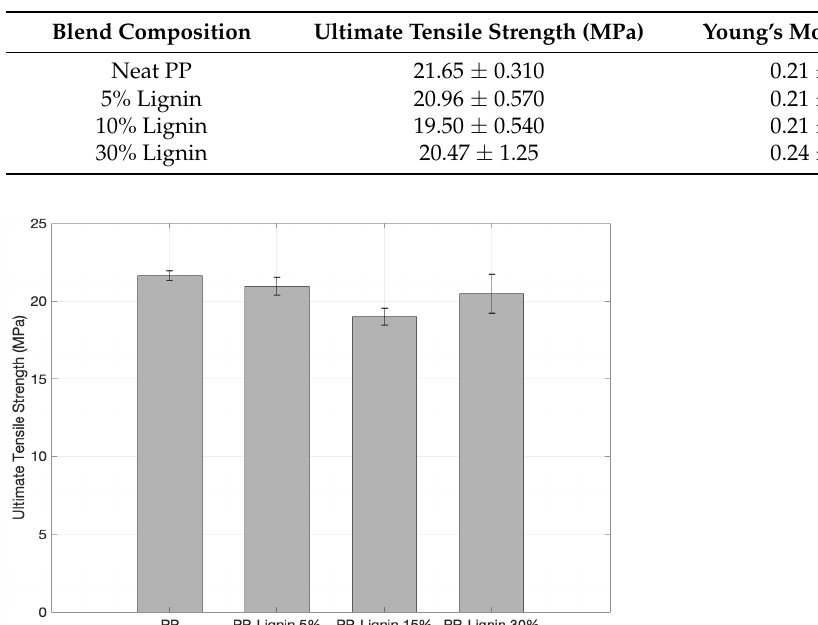
Table 4. Tensile properties of PP-lignin blend.